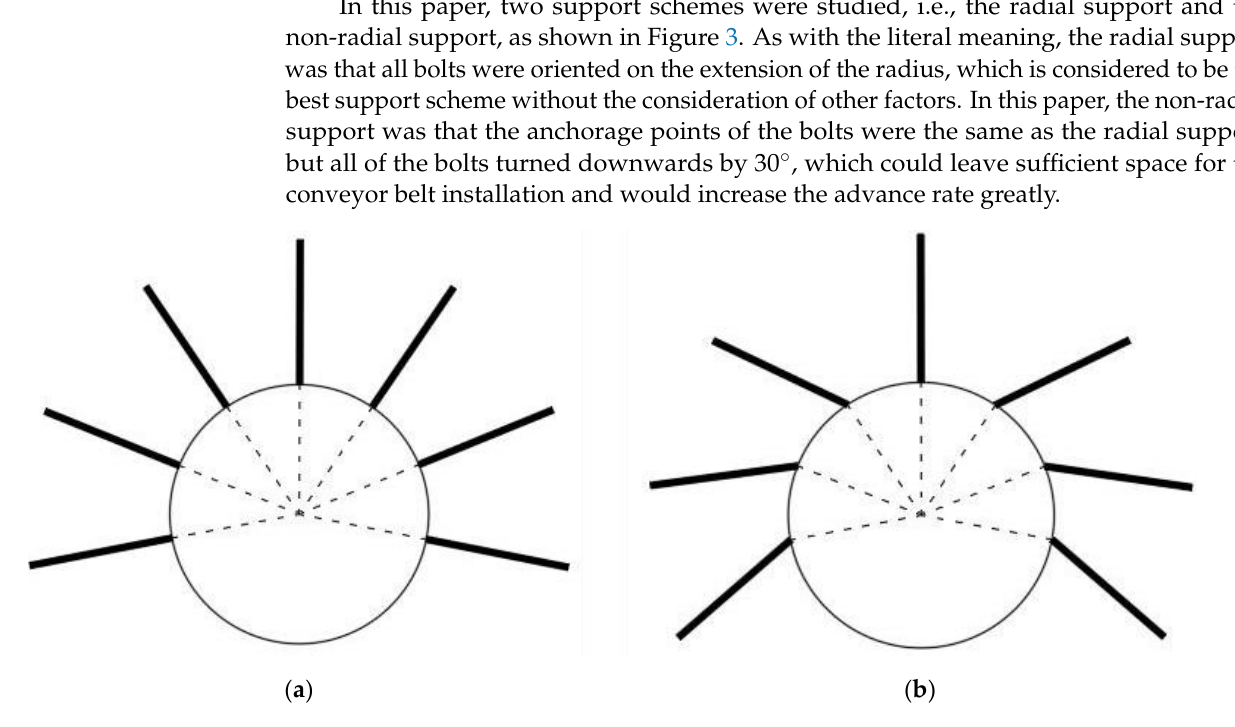
Figure 3. Support scheme applied in the numerical model: ( a ) radial support and ( b ) non-radial support.